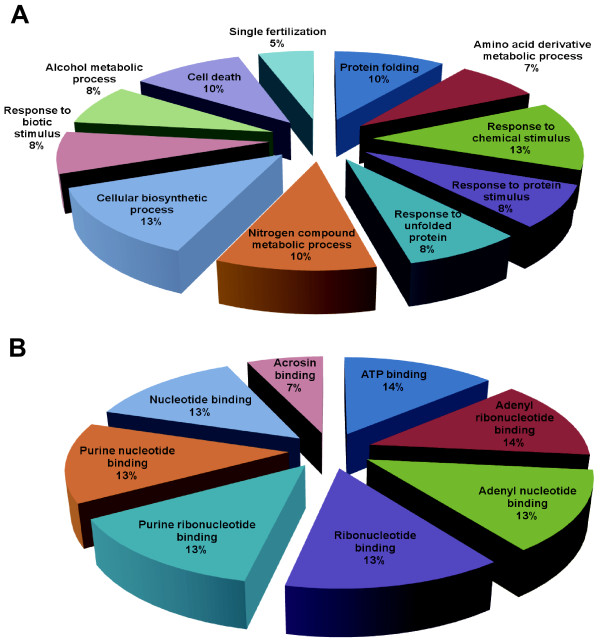
Classification of differentially regulated proteins. An ontological classification of differentially regulated proteins in terms of (A) biological process and (B) molecular function using the Gene Ontology http://www.geneontology.org and UniProt http://www.expasy.uniprot.org websites. The compositions of the identified proteins are presented as percentages of all individually identified proteins.